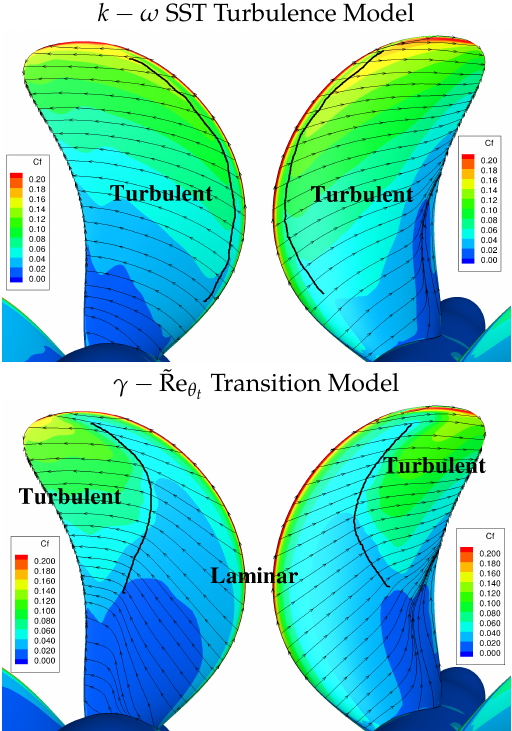
Figure 16. Limiting streamlines and skin friction coefficient using the k − ω SST turbulence model ( top ) and γ − ˜Re θ transition model ( bottom ) at Re = 5 × 10 5 for J = 0.568. Pressure side ( left ) and t suction side ( right